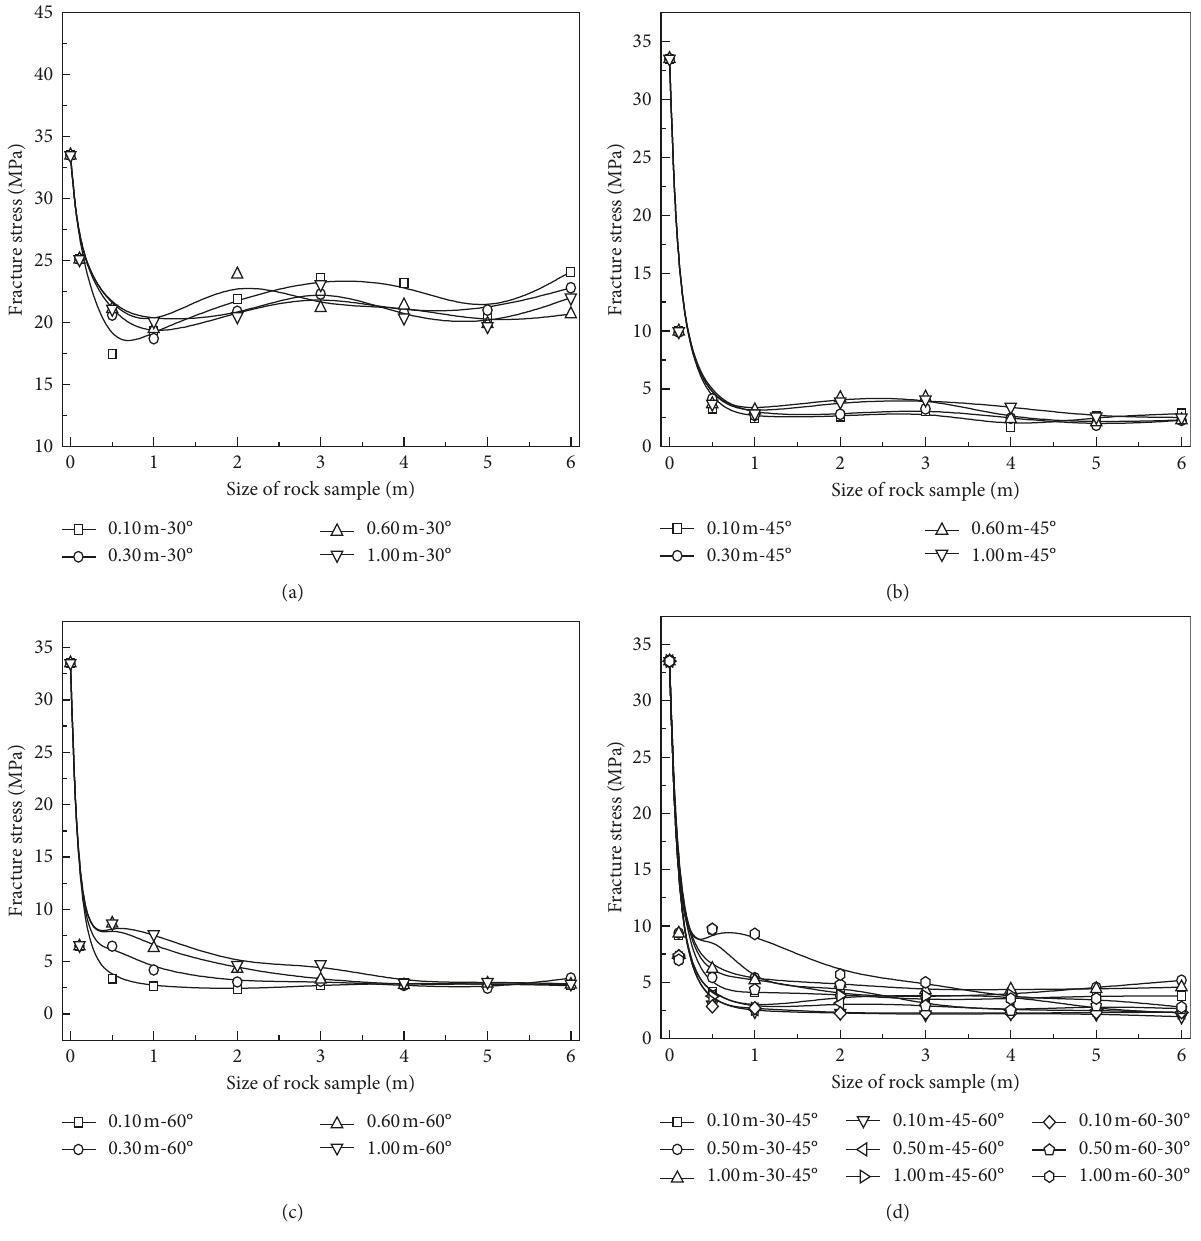
Figure 10: Numerical simulation results of fracture stress of rock samples with different spacings of structure planes under the confining pressure of 1.5MPa: (a) dip angle of 30 ° ; (b) dip angle of 45 ° ; (c) dip angle of 60 ° , and (d) different sizes and different combined dip